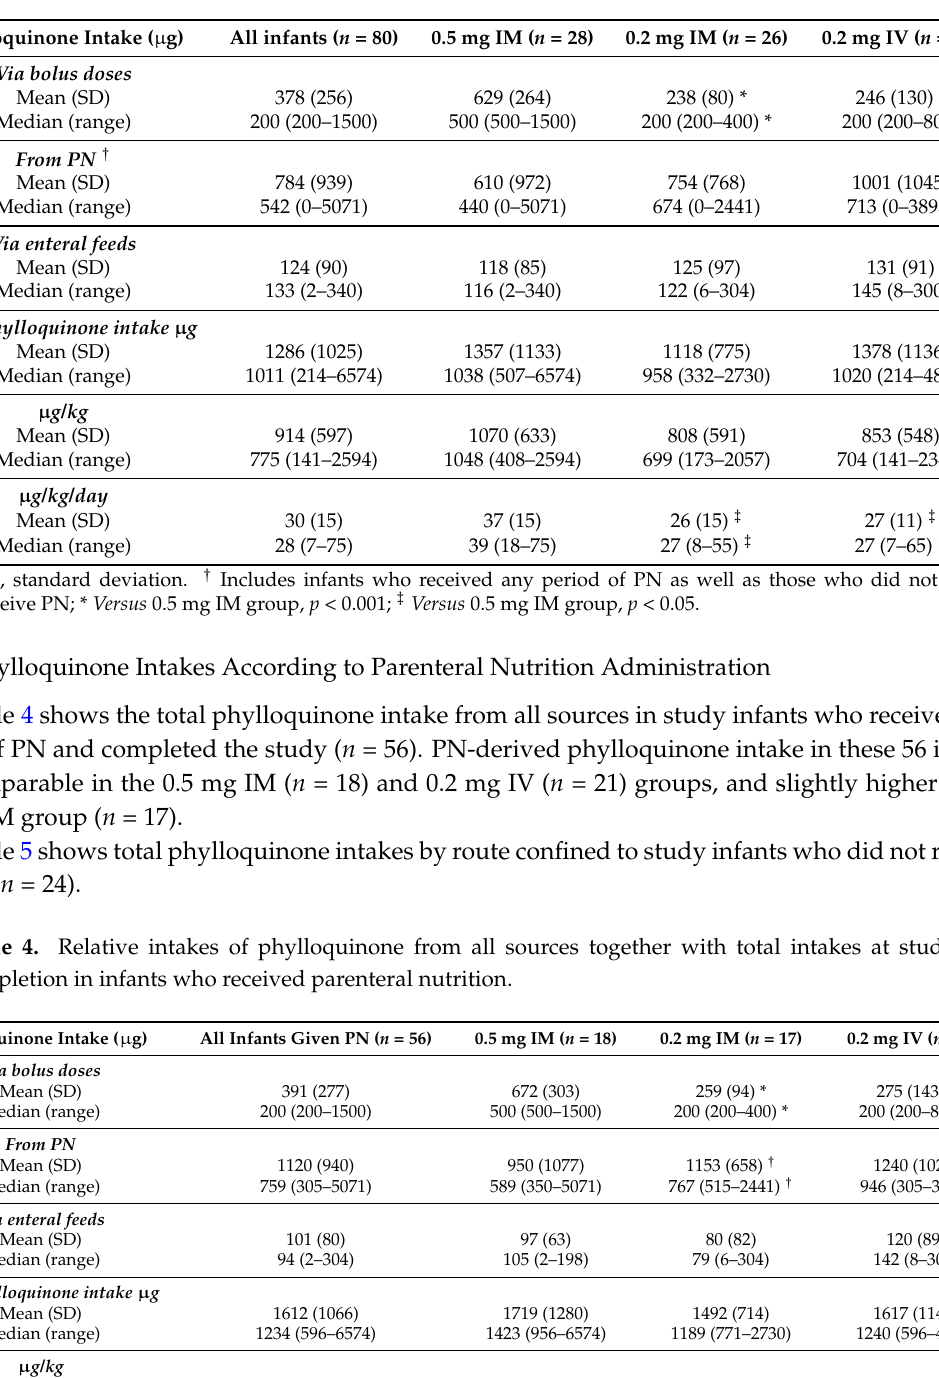
Table 3. Phylloquinone intakes from all sources between birth and study completion (adapted from Clarke et al. [9], with permission).